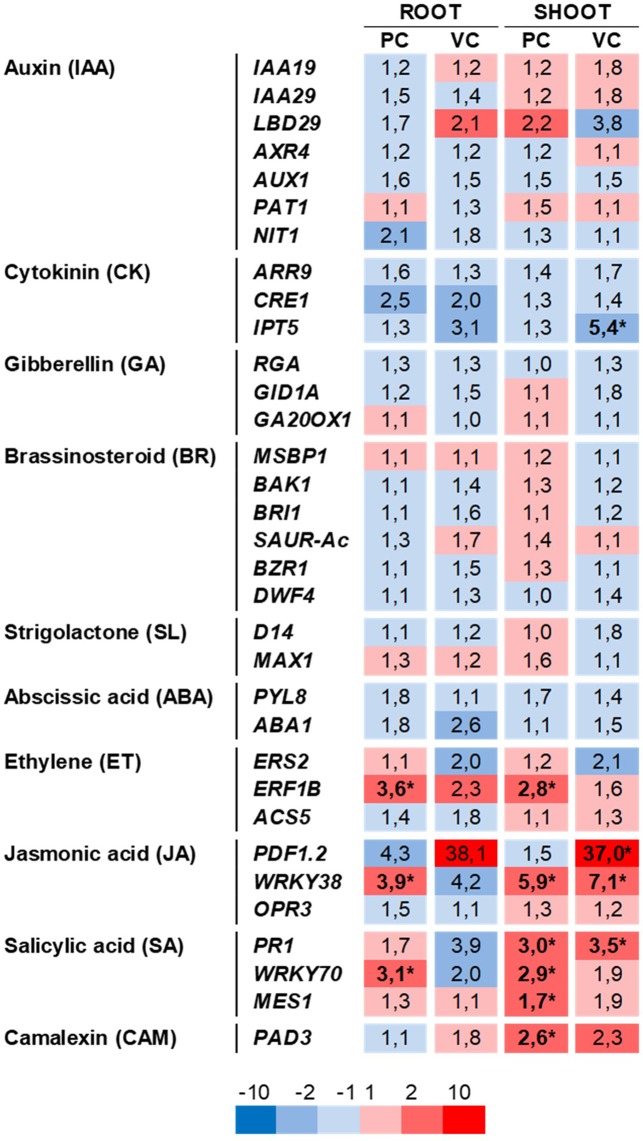
Effects of Bacillus megaterium RmBm31 on the relative expression of phytohormone marker genes in Arabidopsis thaliana Col-0 seedlings roots and shoots. Heatmap of gene expression changes in roots and in shoots induced by RmBm31 in physical contact with the seedling roots 7 days post inoculation (“PC”), or by RmBm31 volatile compounds at 7 dpi (“VC”). Five-day-old seedlings were either mock-treated or treated with RmBm31 inoculum. Seven days post inoculation, root and shoot tissues were harvested (at midday, 8 h light) and transcript levels were quantified by qRT-PCR. The expression level of each gene was normalized to the reference gene At4g26410. Data are mean ± SEM of four biological replicates, each from an independent experiment. Fold changes (Fc) of gene expression are in red for induction and in blue for repression in comparison to the mock. Stars indicate statistically significant differences according to a Mann–Whitney–Wilcoxon test (ns, nonsignificant; *, P < 0,05).